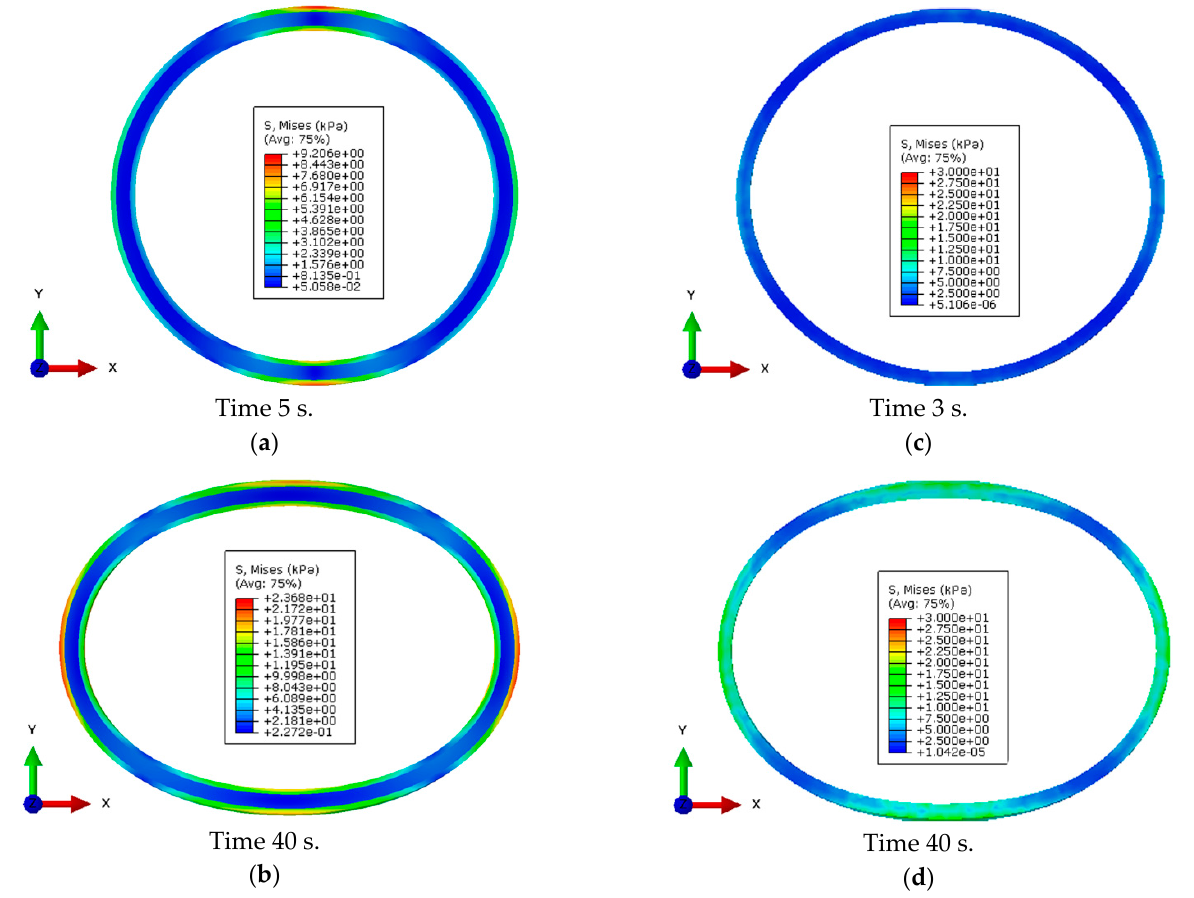
Figure 6. Numerical analysis of ring stiffness and load at 30% flexibility of the pipe investigated: ( a , b ) selected time steps in compressing the PPM sample; ( c , d ) selected time steps in compressing the PPS sample.